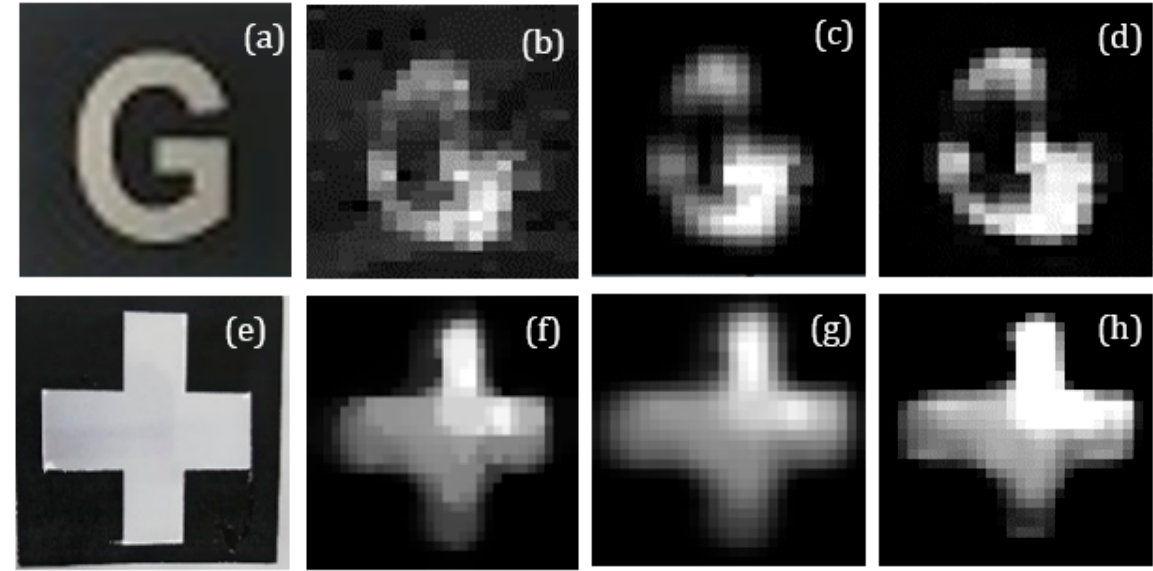
Figure 11. Image reconstruction results at different methods using random patterns in clear water under 300 measurements: ( a , e ) original image, ( b , f ) SPI image, ( c , g ) SRCNN image, and ( d , h ) our method image.